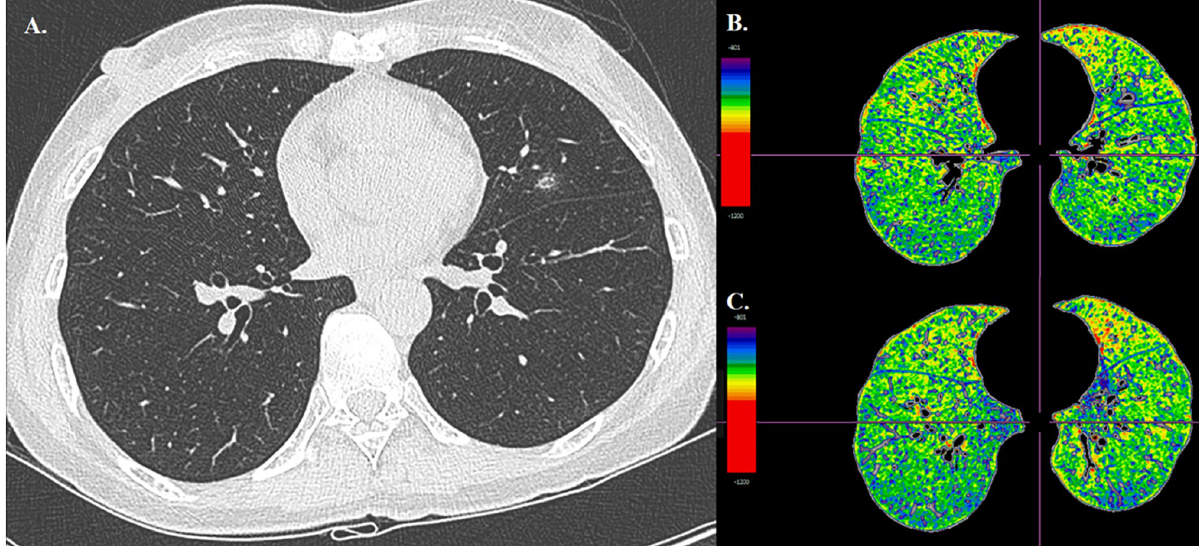
Fig 5. Representative case of prolonged air leak after anatomical segmentectomy. A 54 year-old female patient underwent anatomical segmentectomy for a persistent subsolid nodule approximately 1cm in left lingular segment (A). On pre-operative chest CT images, emphysema index of the entire lung is 11.6% and the lobe-specific emphysema index is 17.8% (B, C). Prolonged air leak occurred after lingular segmentectomy.